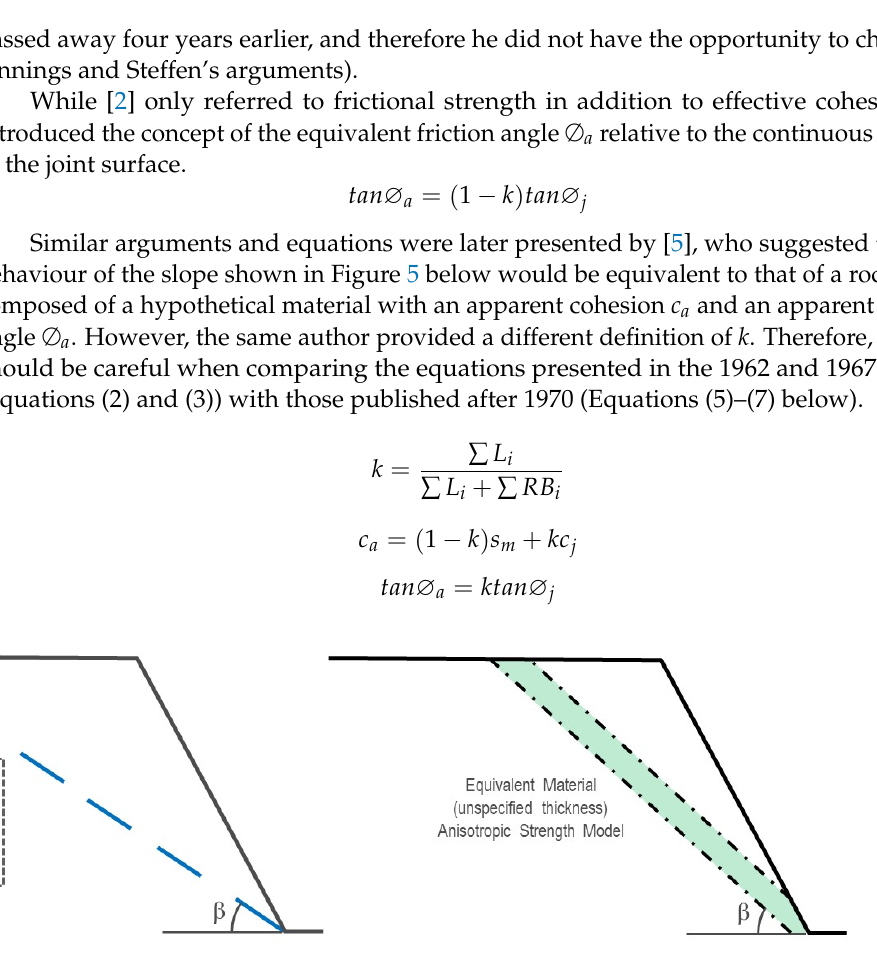
Figure 5. Simple slope problem showing how the presence of rock bridges is modelled using equivalent continuum methods.